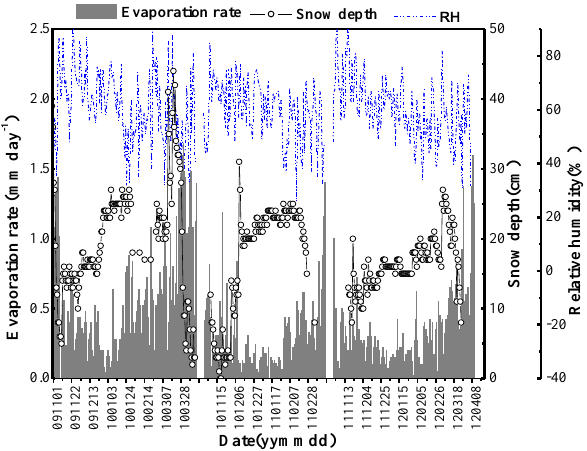
− 1 ) around Changbai Mountain Fig. 4. EC concentrations (ng g −1 ) around Changbai Mountain from the surveys in 687 Fig. 4. EC concentrations (ngg from the surveys in January 2010 and